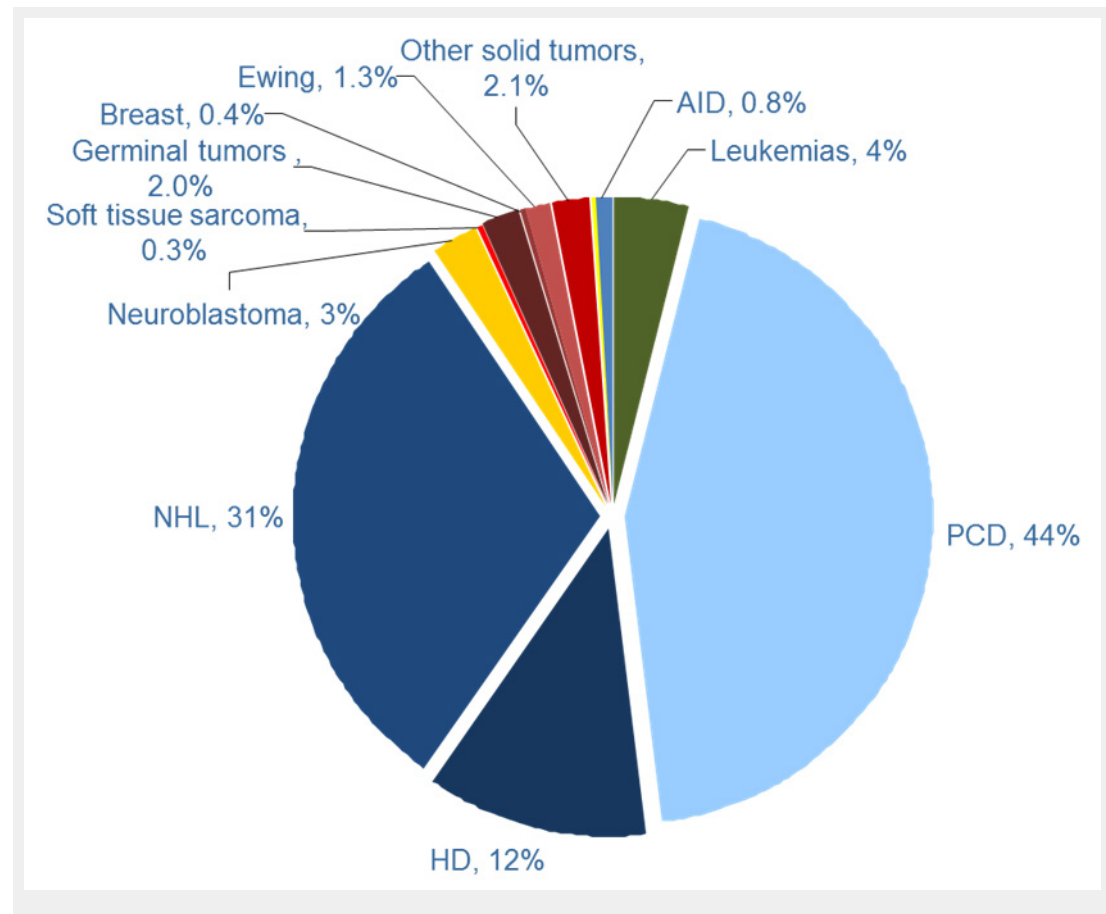
Figure 2B Indications for autologous HSCT in Europe in 2010 (reprinted from: Passweg JR, Baldomero H, Gratwohl A, Bregni M, Cesaro S, Dreger P, et al.; for the European Group for Blood and Marrow Transplantation (EBMT). The EBMT activity survey: 1990–2010. Bone Marrow Transplant. 2012;47(7):906-23 [3]). Abbr: PCD: plasma cell disorders, HD Hodgkin Lymphoma, NHL Non Hodgkin Lymphoma, AID Autoimmune